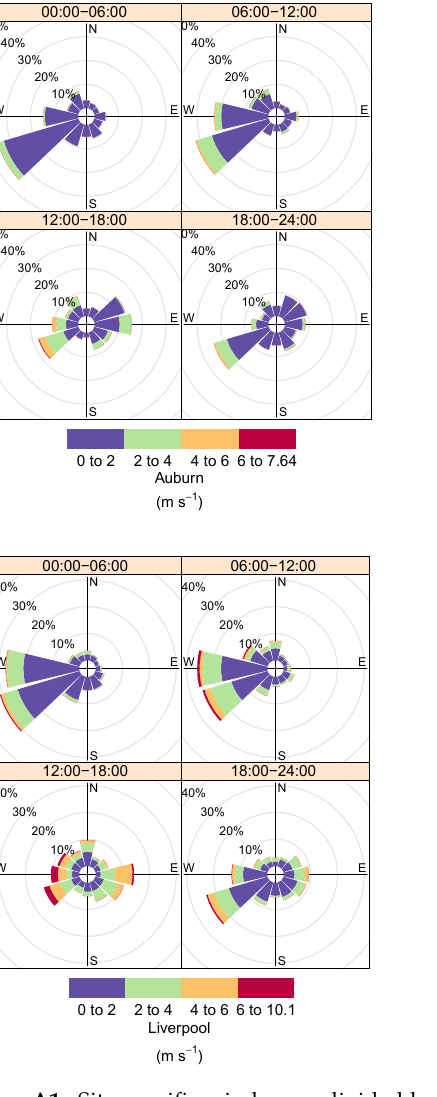
Figure A1. Site-specific wind roses divided by time of day. Measurements were binned into four periods: 00:00–06:00, 06:00–12:00, 12:00–18:00 and 18:00–00:00. Colour represents wind speed, while distance from the origin represents the proportion of total wind direction measurements present in each 30° segment.